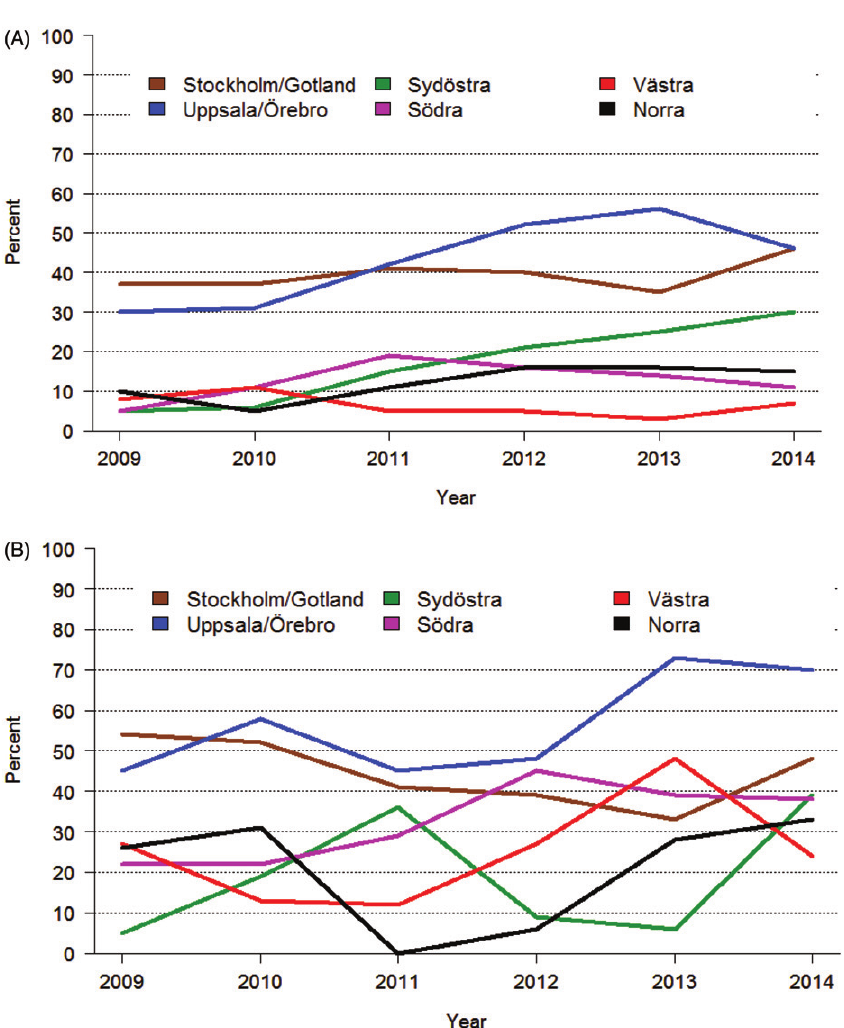
Figure 1. Proportion of patients receiving short-course radiotherapy (scRT) with a delay to surgery > 3 weeks rather than immediate surgery in six health care regions in Sweden 2009 – 2014. The Stockholm/Gotland and Uppsala/ € Orebro regions participated in the Stockholm III trial (47) where patients could be randomized to delayed surgery. However, the number of randomized patients was far less than the number of patients treated with a delay, and, furthermore, randomization stopped in January 2014 but a delay continued to be used. A delay was used also in other regions but one during the latter part of the time period for patients below 75 years (A). Several patients above 75 years had surgery delayed, with no real change during the time period